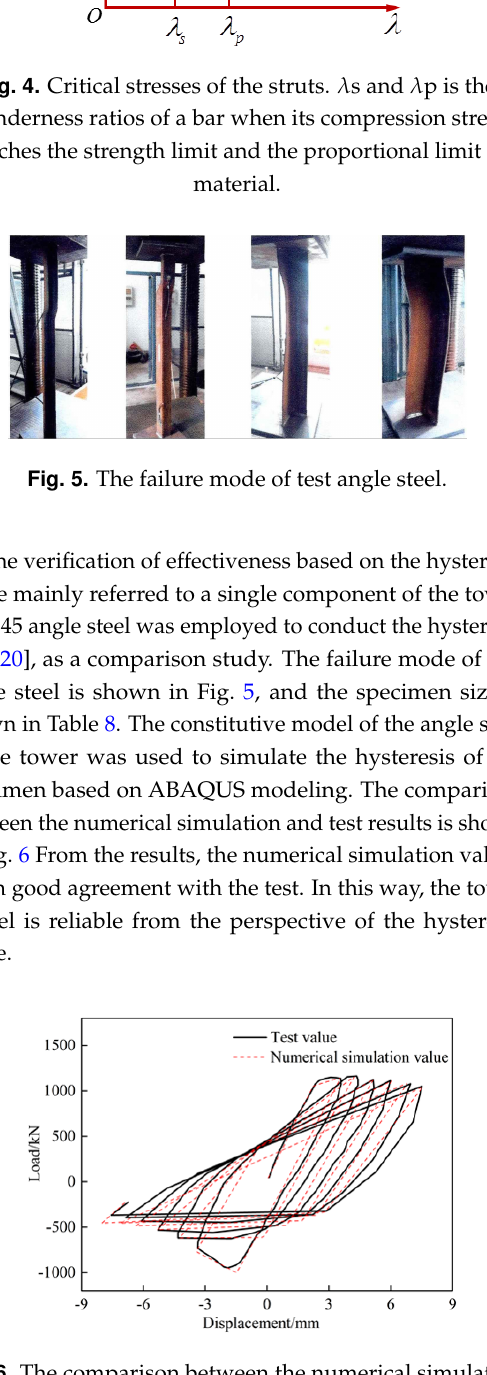
Fig. 6. The comparison between the numerical simulation results and the test